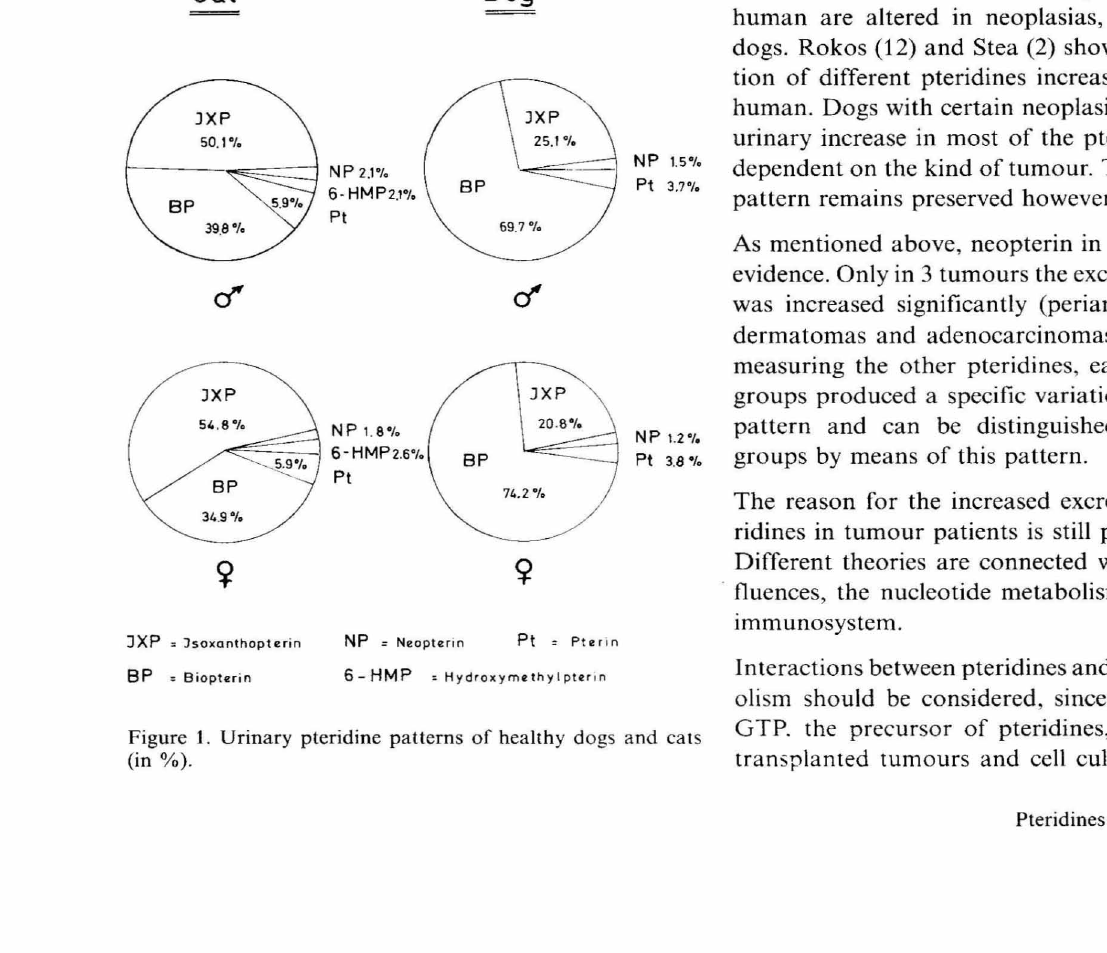
Figure 1. Urinary pleridine patterns of healthy dogs and cats (in